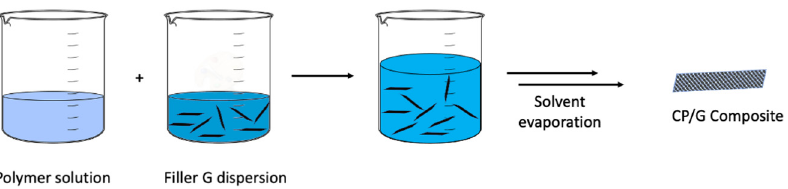
Figure 10. Figure 10. Scheme of the common solvent mixing procedure for the fabrication of graphene/CP composites.